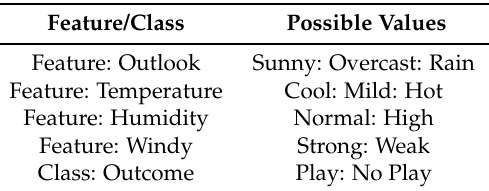
Table 3. Classifier’s test